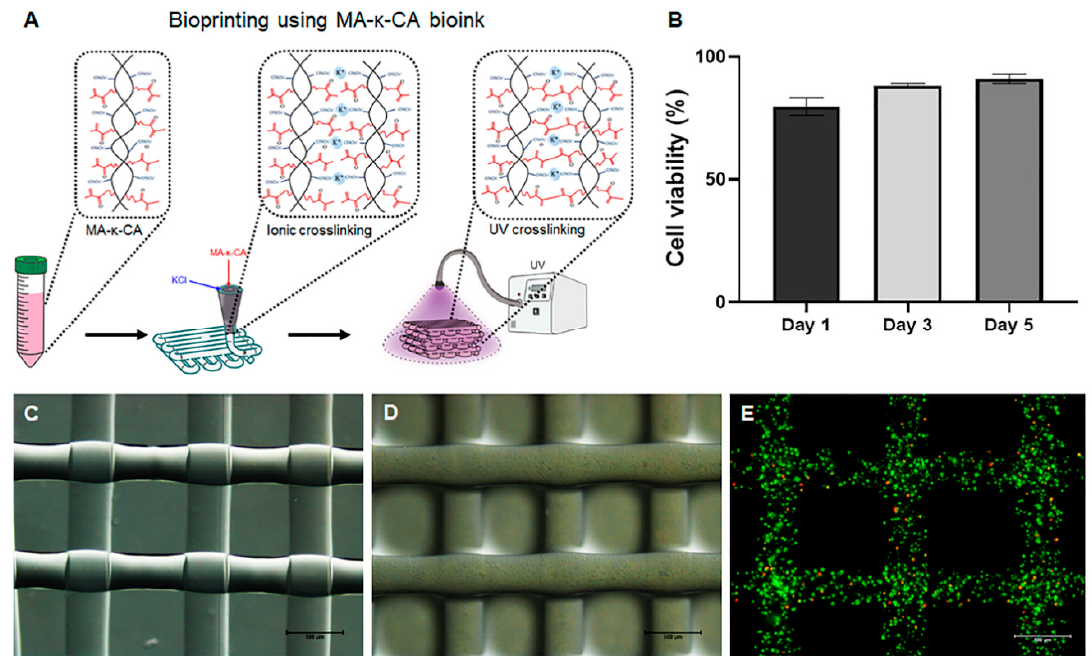
Figure 7. Dual crosslinking (Ionic and UV) mechanism and microscopic images of printed construct. ( A ) Ionic and UV crosslinking mechanism of cell-laden MA- κ -CA bioink for 3D bioprinting. ( B ) Cell viability assay of 3D printed cell-laden MA- κ -CA hydrogel. ( C ) Microscopic image of MA- κ -CA hydrogel fiber. ( D ) Microscopic image of encapsulated MA- κ -CA hydrogel fiber at 24 h. ( E ) Live/Dead assay image of 3D printed MA- κ -CA hydrogel fiber with 2% alginate at day 5 (Scale bars = 500 μ m).